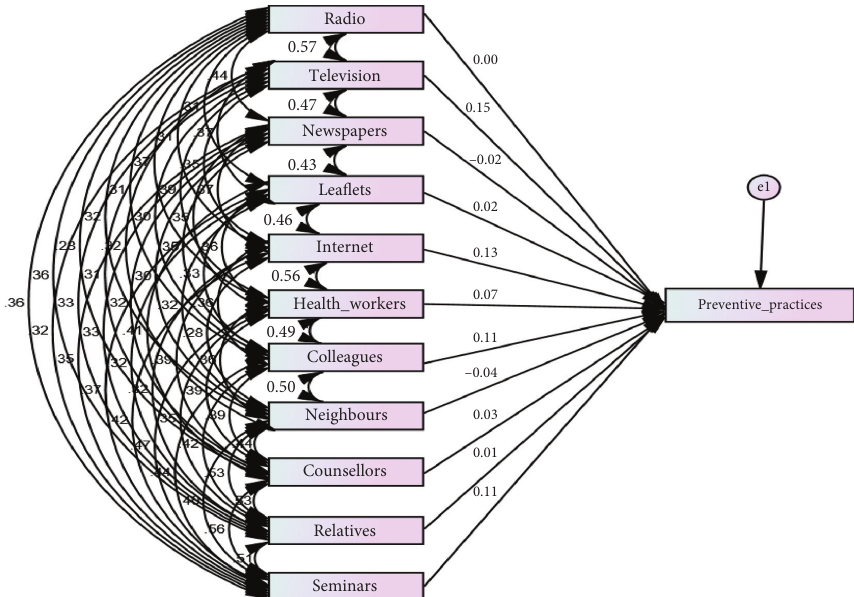
Figure 3: Health communication channels and residents’ preventive practices against the HBV model. Table 7: Standardised regression weights of health communication channels and preventive practices of